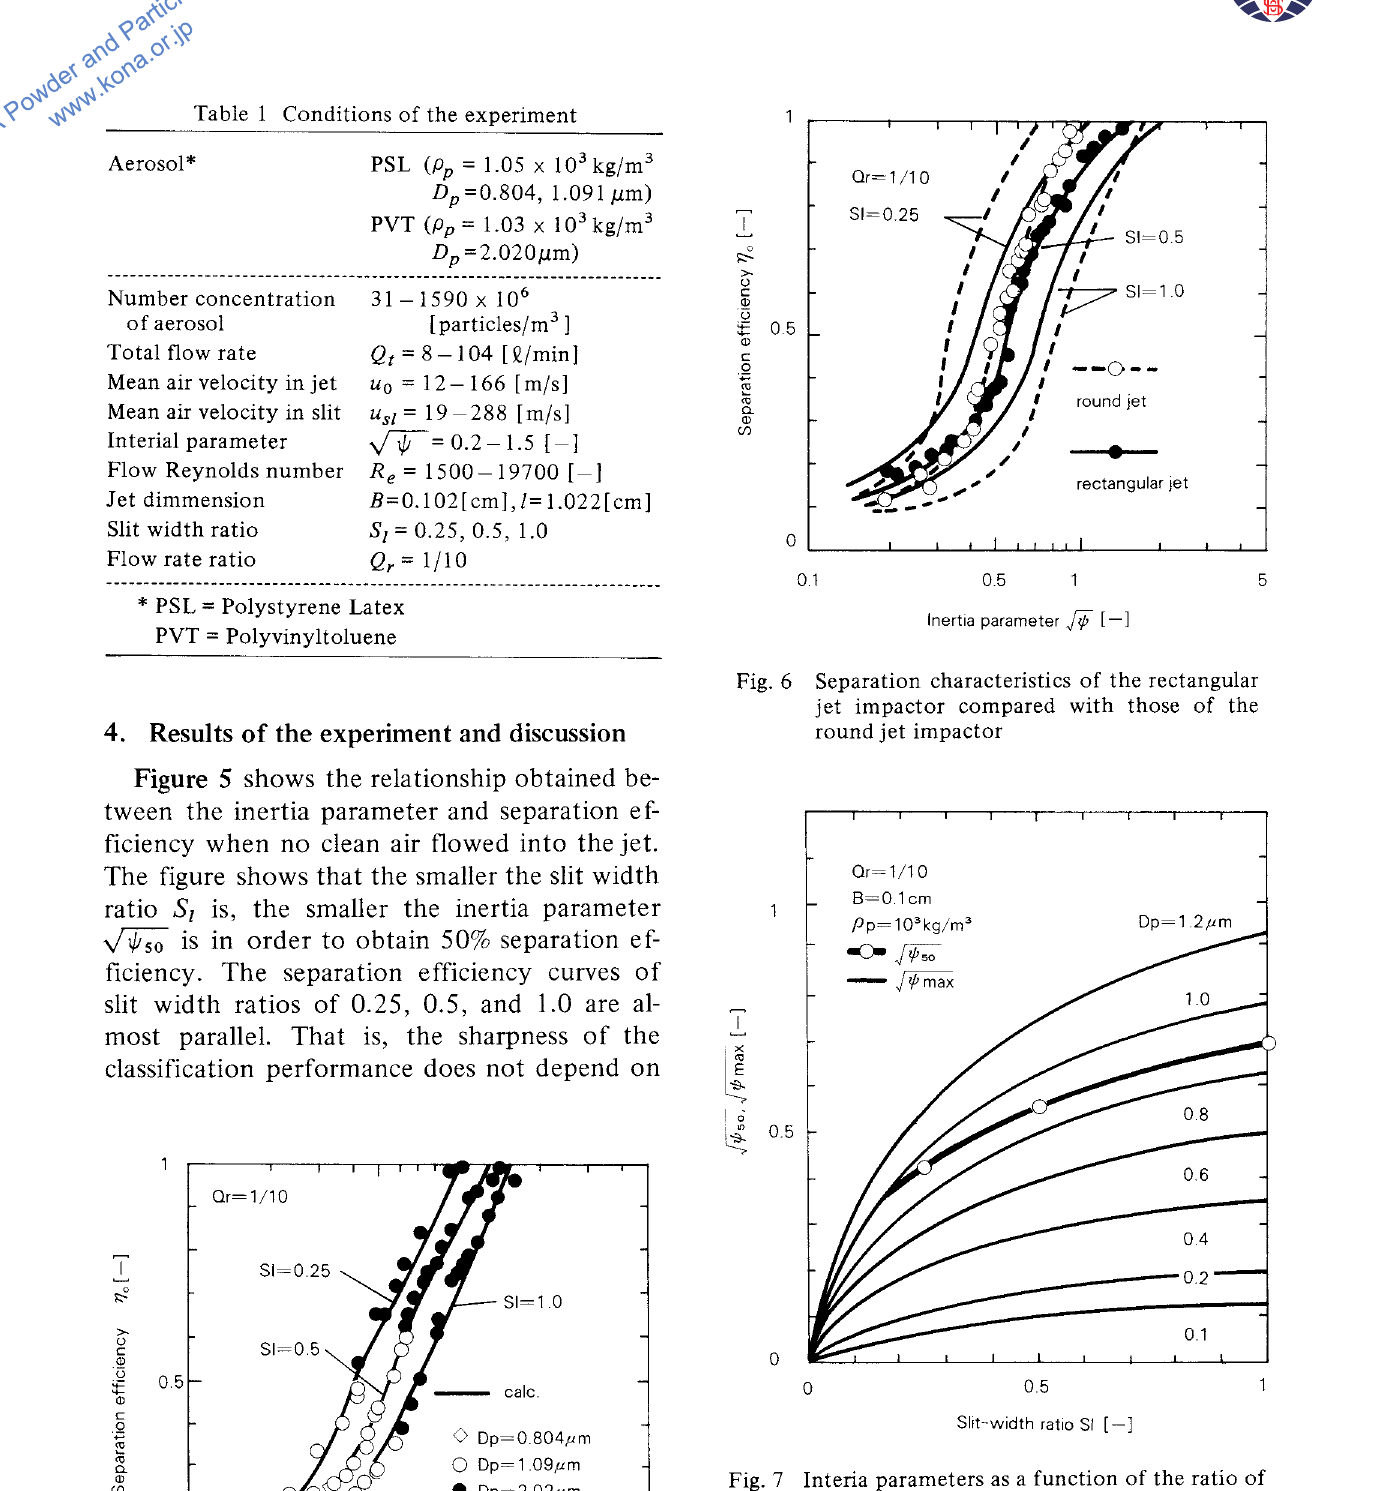
Fig. 7 Interia parameters as a function of the ratio of slit gap to jet breadth